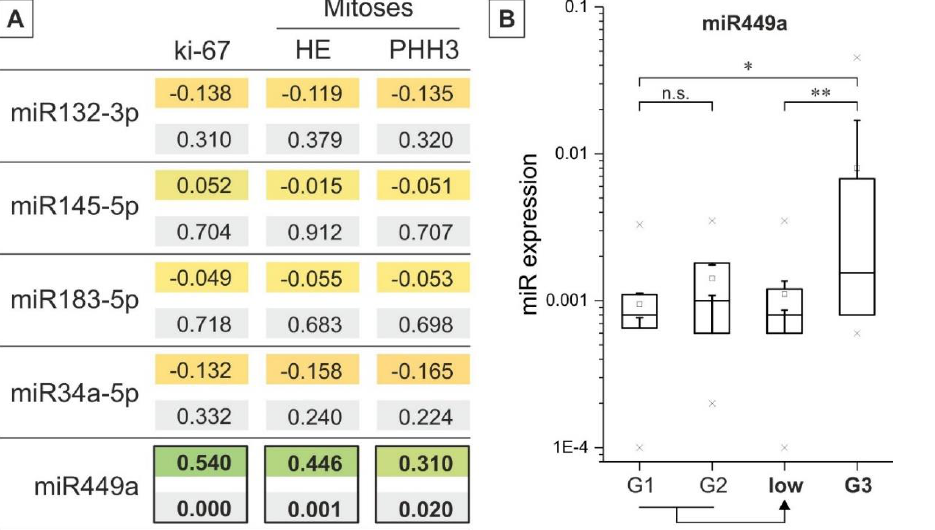
Figure 2. ( A ) Correlation analysis microRNAs (miRNA) expression and markers of proliferation and mitosis. The upper value stands for the Pearson correlation coefficient (absolute values), and the lower value is the related p value; significant differences are highlighted (black rectangles). ( B ) Quantitative analysis of pNET-miRNA expression versus grading. miRNA expression is plotted via box plots versus grading of pNET cases. Additionally, the expression levels were summarized for G1 and G2 pNET cases. * p < 0.05, ** p < 0.01 ( t -Test and ANOVA).